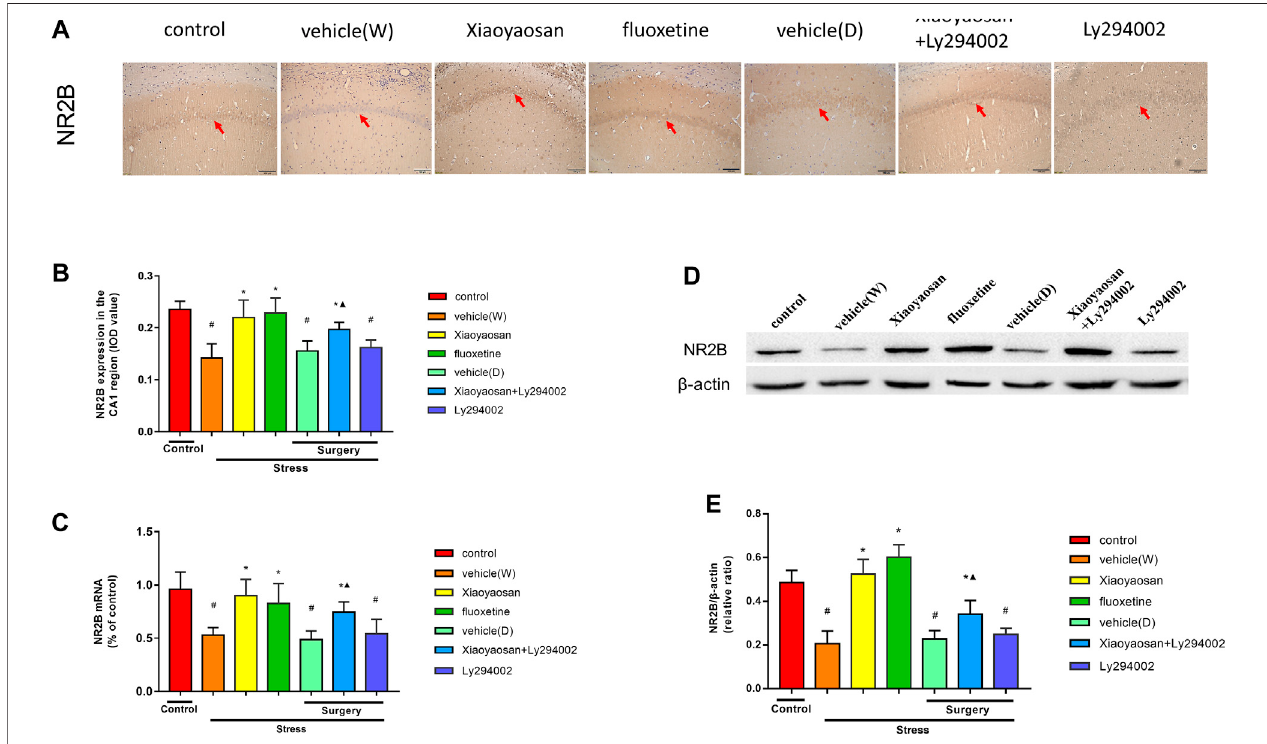
FIGURE 6 | Xiaoyaosan elevates the expression of NR2B in the hippocampal CA1 region of CUMS rats (A) Representative micrographs of immunohistochemical staining (sections were counterstained with hematoxylin; original magni fi cation, × 200) and (B) quantitative analysis showing the expression of NR2B in the hippocampal CA1 region (C) NR2B mRNA level in the hippocampal CA1 region (D) Representative images and western blot analysis (E) of western blot assay showing the relative expression of NR2B in the hippocampal CA1 region. All data are expressed as the mean ± SD. # p < 0.05 compared to the control group; * p < 0.05, compared to the vehicle (W) group; ▲ p < 0.05 compared to the Ly294002 group, n (cid:2)